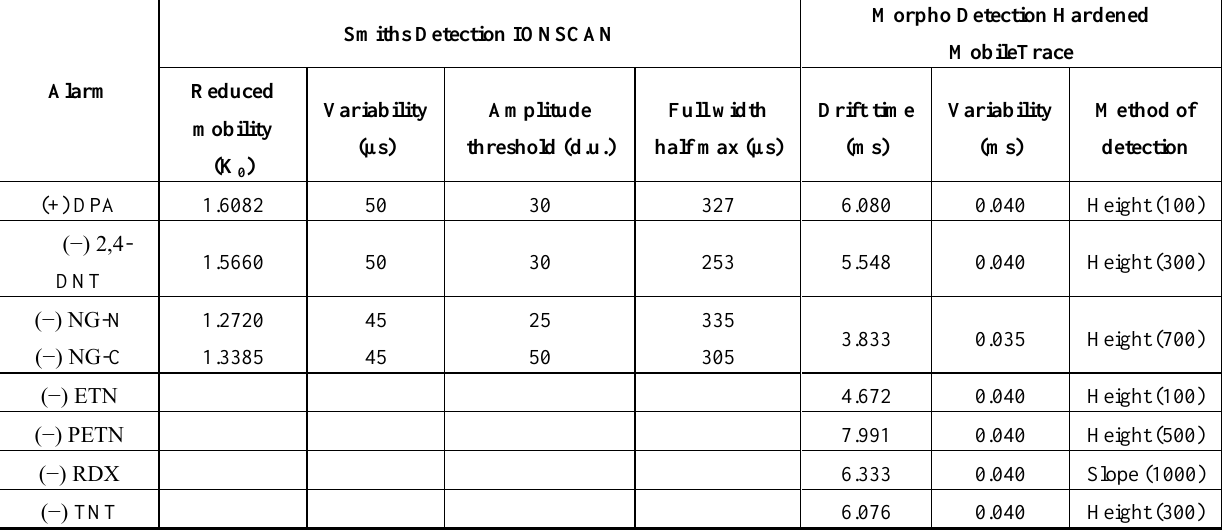
Table 2. Alarm threshold for analytes of interest for benchtop and portable IMS